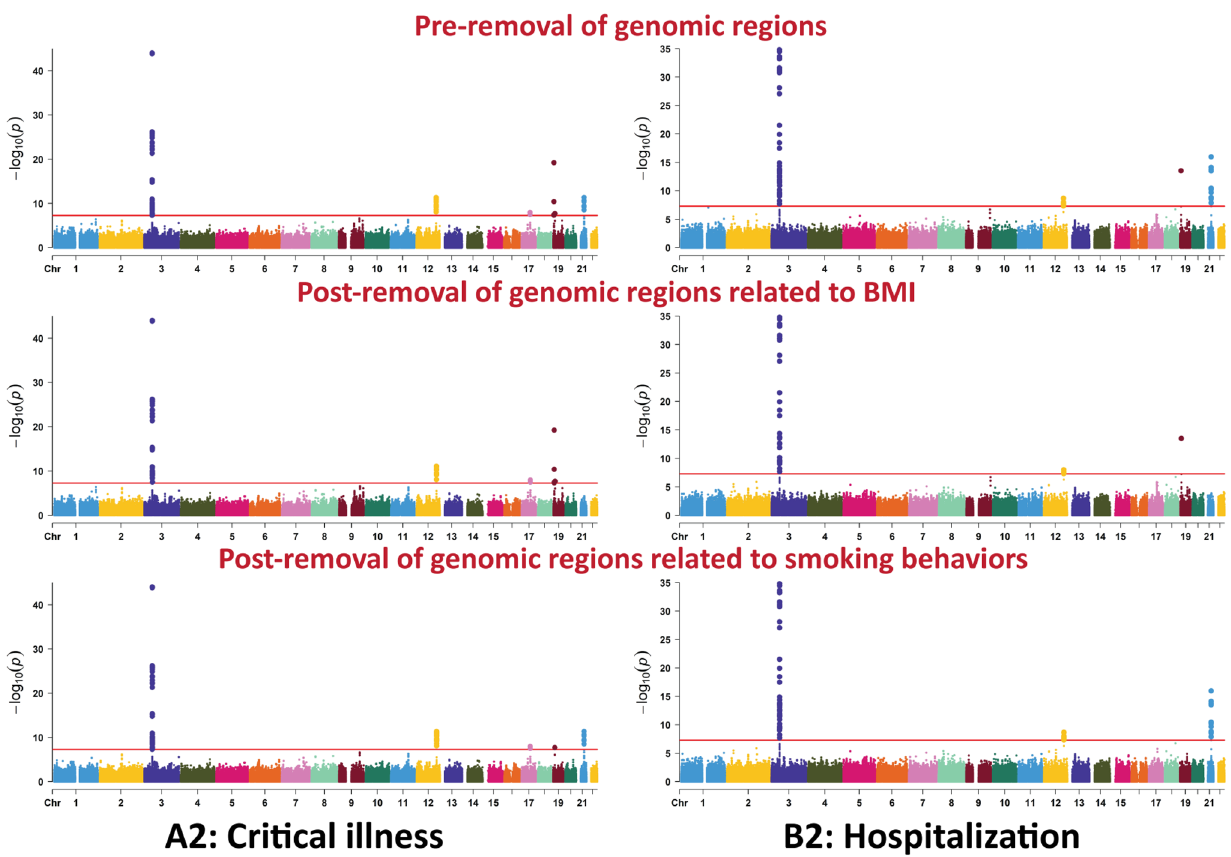
Figure 2. Manhattan plots of the COVID-19 GWAS meta-analysis for pre- and post-removal of genomic regions associated with smoking behaviors and BMI in European descnt population. A2: very severe respiratory confirmed COVID-19 cases versus population: 4606 cases and 702,801 controls, B2: hospitalized COVID-19 cases versus population: 9373 cases and 1,197,256